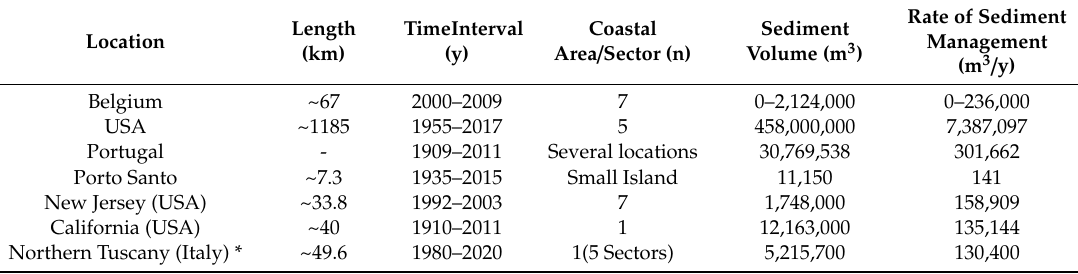
Table 9. Table summarizing sediment budget calculations from di ff erent areas.